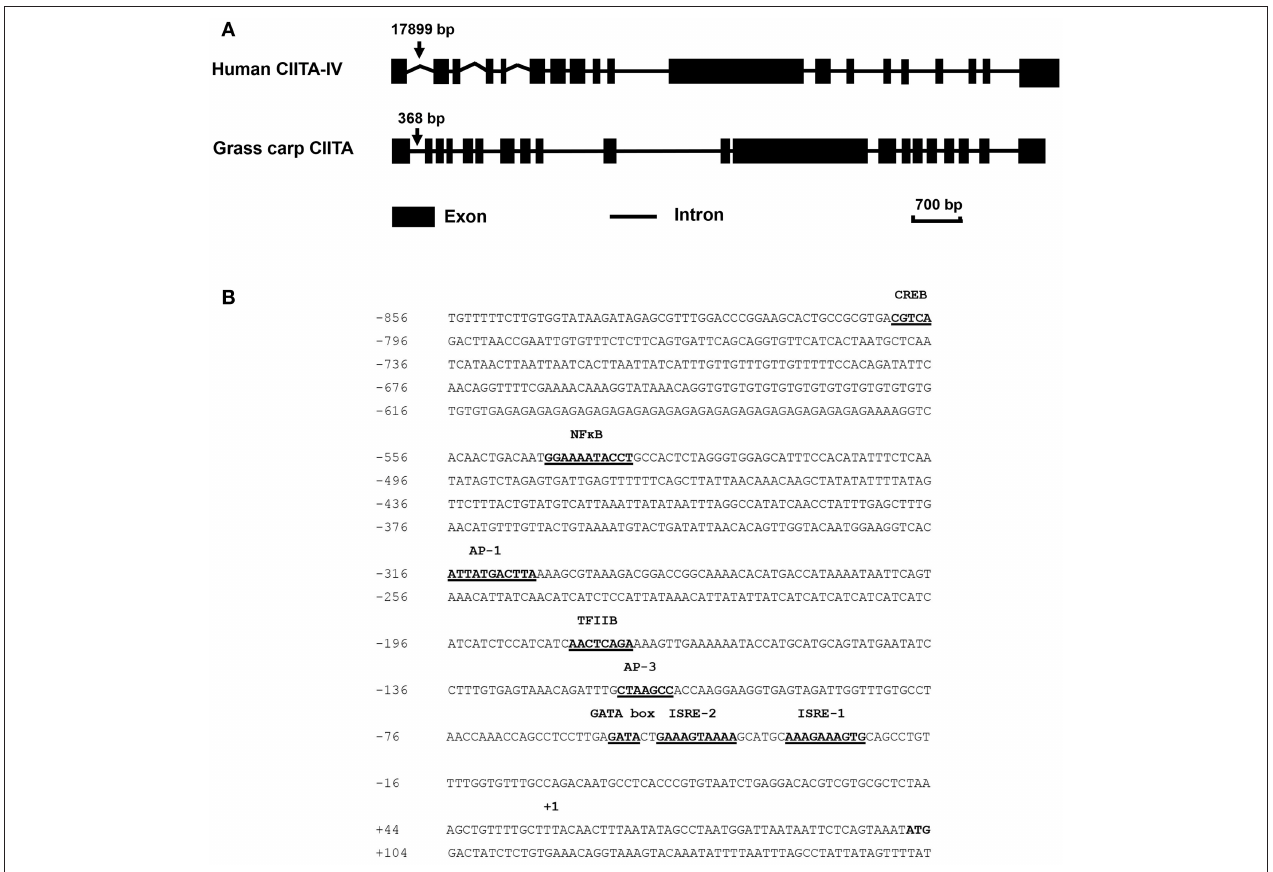
FIGURE 1 | Schematic diagrams of the CIITA gene in human and grass carp, and prediction of the transcription factor binding sites in the promoter region of grass carp CIITA. (A) Human type IV CIITA gene sequence was obtained from UCSC Genome Browser, and grass carp CIITA gene sequence was acquired by local blast from grass carp genomic data downloaded from official National Center for Gene Research website (http://www.ncgr.ac.cn/grasscarp/). (B) The putative motifs including CREB, NF κ B, AP-1, TFIIB, AP-3, GATA box, and two ISREs were predicated. The transcriptional start site was designated by +